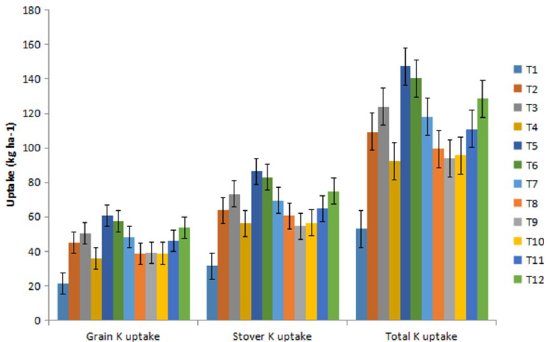
Fig 3. Potassium uptake in chickpea under various INM